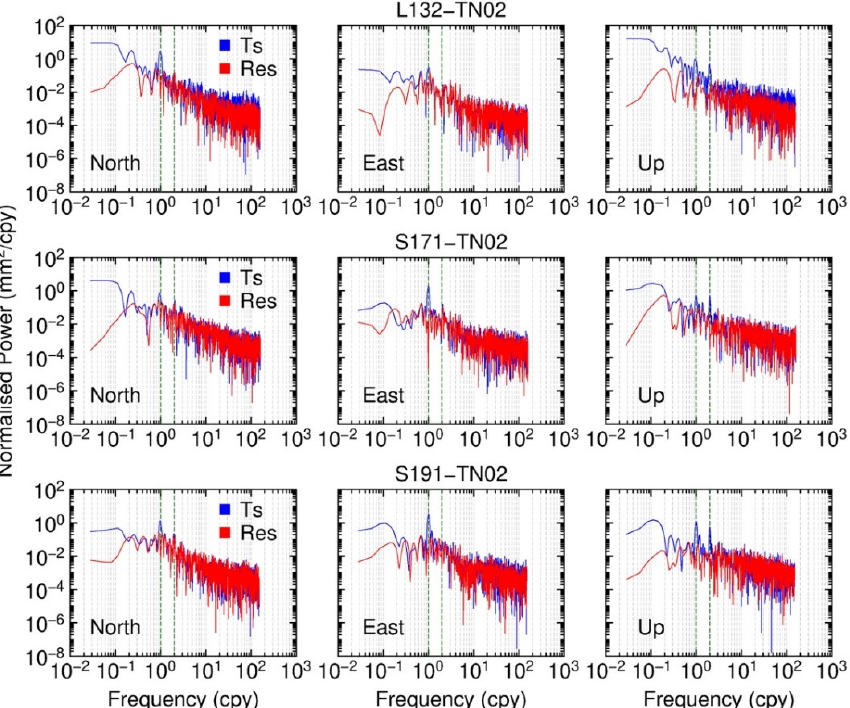
Figure 6. Baseline coordinate time-series power spectra L132–TN02, S171–TN02 and S191–TN02, where the x -axis is frequency with the unit of cycles per year, and the y -axis is the normalized power. The blue lines are the baseline time series, and the red lines are the residuals after removing the fitting models. The vertical green dashed lines indicate annual and semiannual frequency. Table 4. Baseline RMS statistics (station-TN02) before and after removing the fitting models.